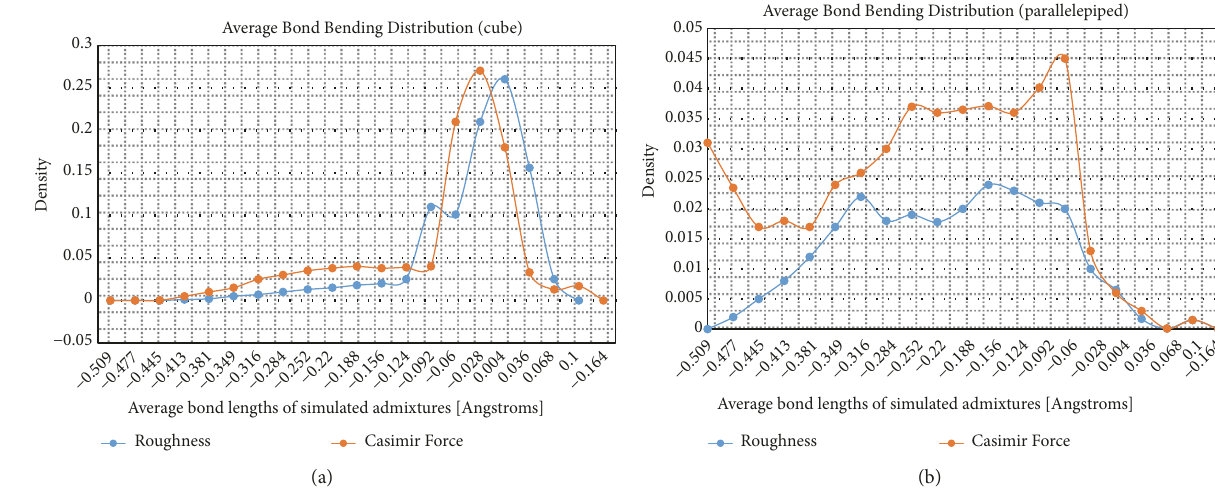
Figure 4: (a, b) Distribution of deviations of the mean values of the covalent